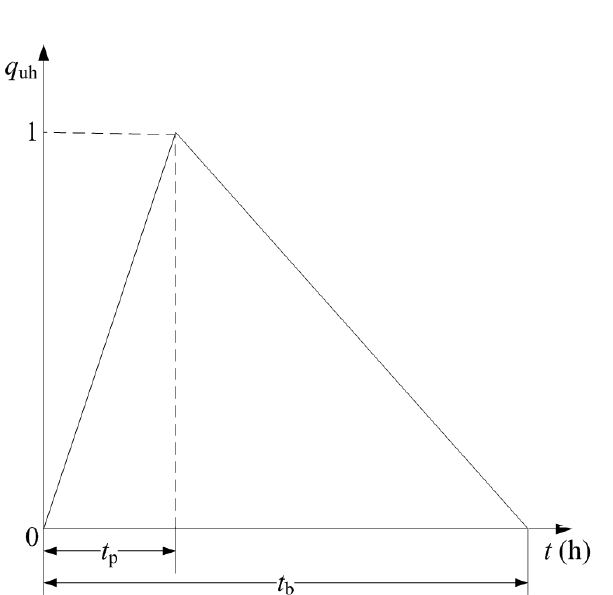
Figure 4. Effect of a basin level UH parameter t adj on the CV of UH time base t b